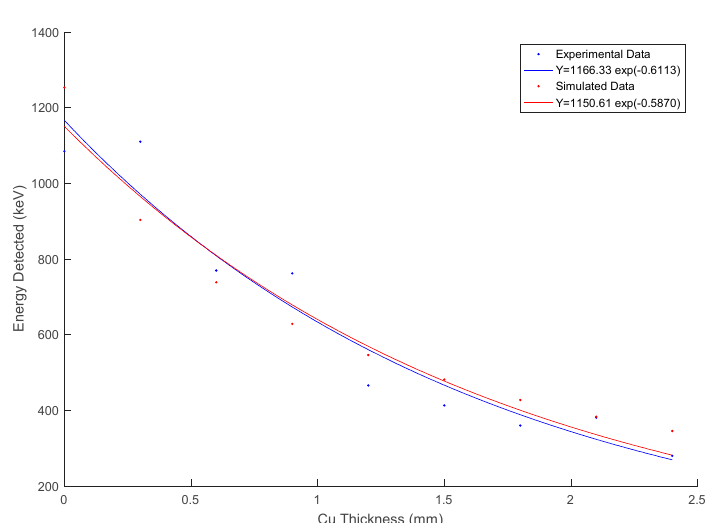
Figure 6. Simulated vs experimental results for a photon distribution governed by Kramers’ law with E max = 204 keV and k [ Kram ] = 0.0146. The above values are chosen in such a way to obtain the best possible match between fitted curves of experimental and simulated results. Both curves for experimental and simulated results are fitted to a first order exponential curve with fit parameters shown in the legend.